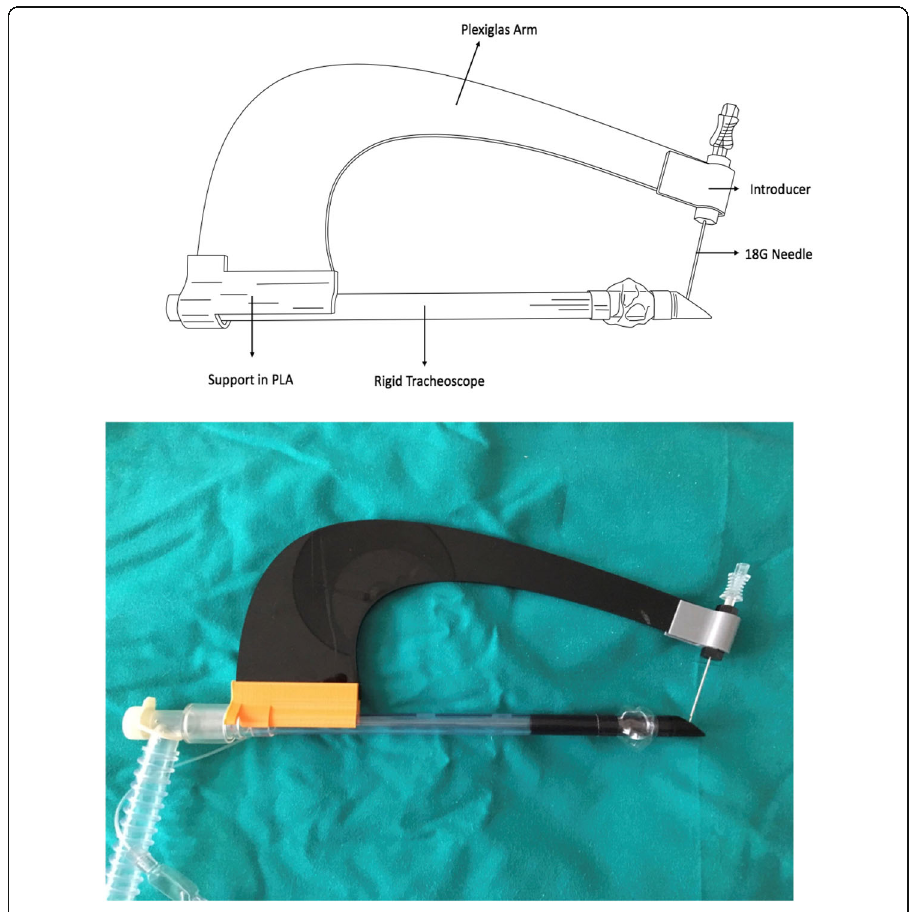
Fig. 1 Technical design of the translaryngeal Tracheostomy Needle Introducer. PLA, polylactic